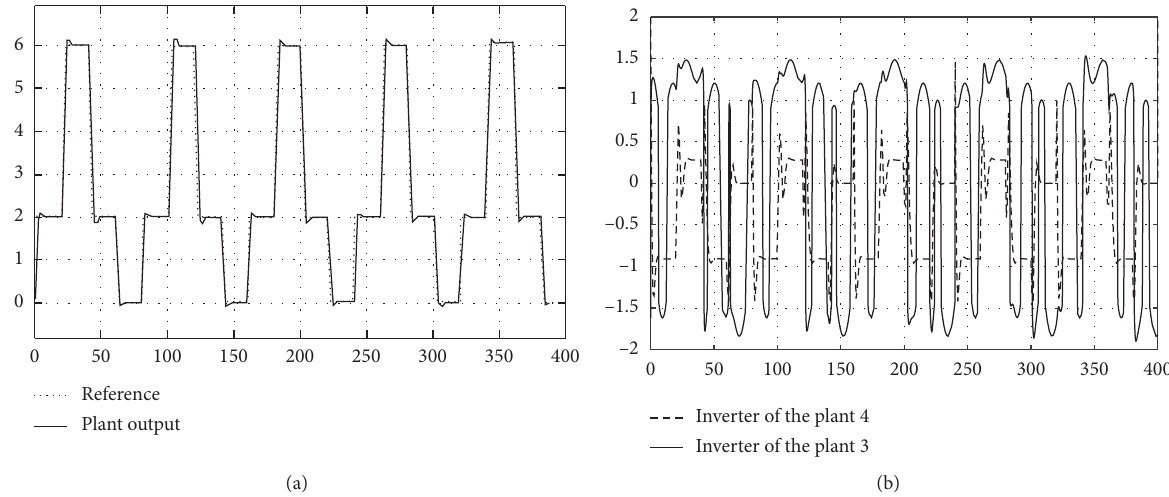
Figure 7: (a) Plant outputs and reference for plant 3 and plant 4. (b) Controller outputs for plant 3 and plant